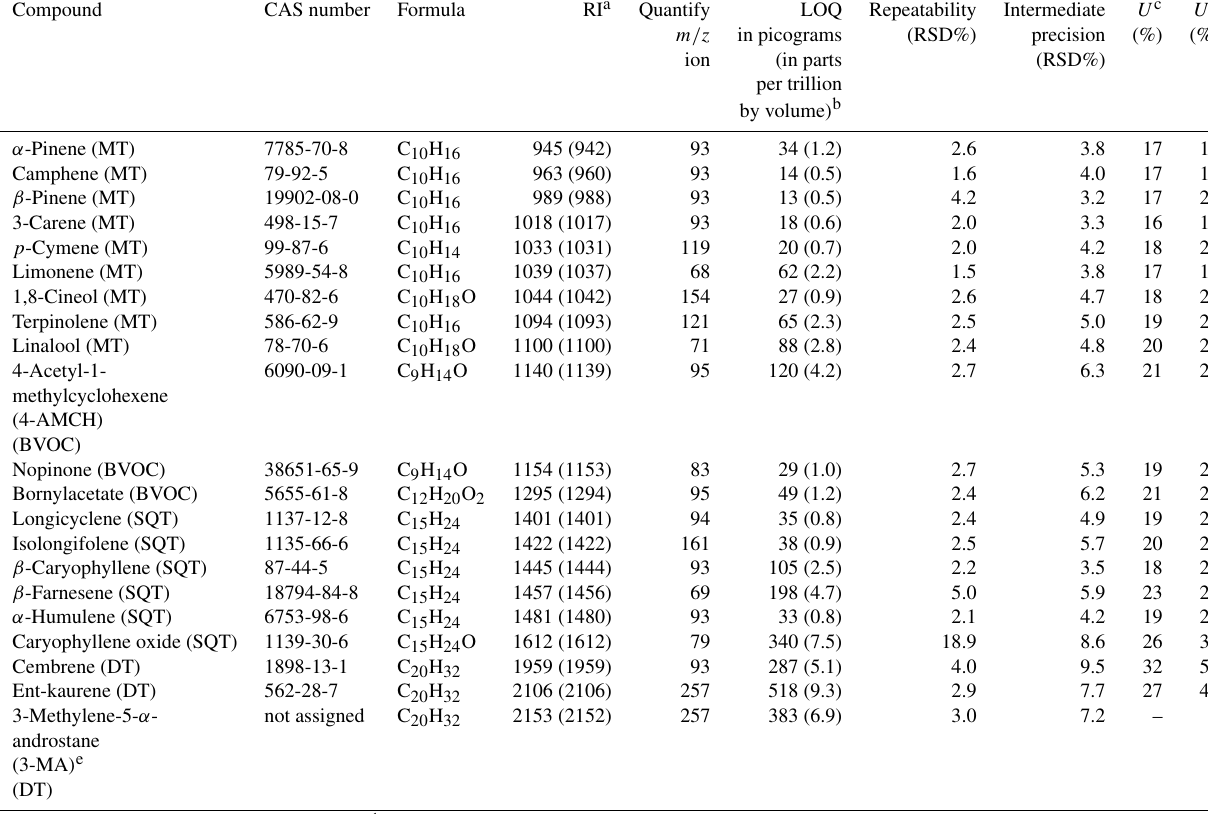
Table 1. List of analytes, corresponding retention indices (RIs) and analytical figures of merit. Compound